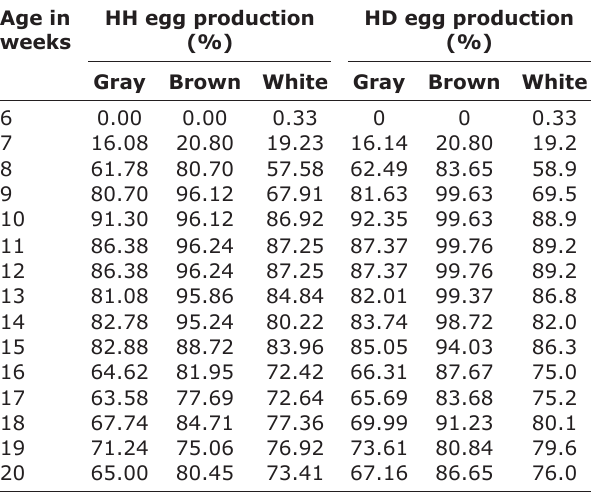
Table-2: HH and HD egg production (%). Age in weeks